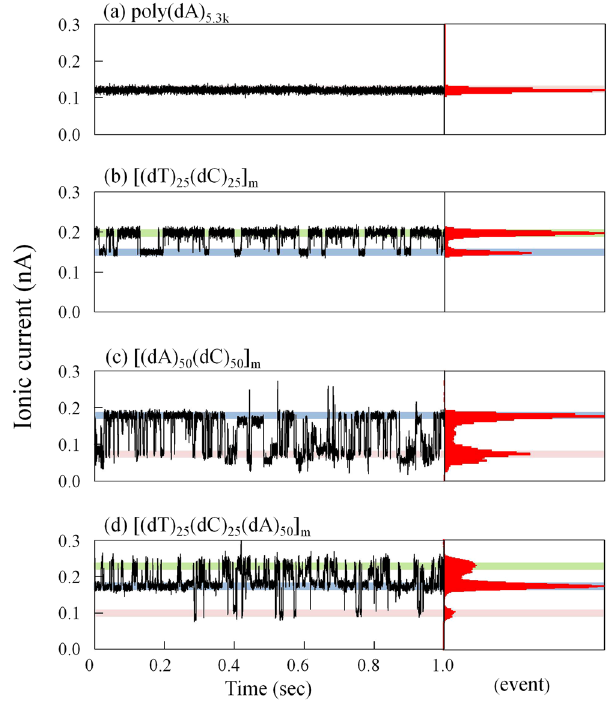
Figure 6. Short-term time trace of the ionic current while the homopolymer or block copolymer remained in the nanopore. Typical time trace of the ionic current for 1 sec while ( a ) poly(dA) 5.3k , ( b ) [(dT) 25 -(dC) 25 ] m , ( c ) [(dA) 50 -(dC) 50 ] m , and ( d ) [(dT) 25 -(dC) 25 -(dA) 50 ] m remained in the nanopore. Each applied voltage was 100 mV. Each current signal was filtered at 2 kHz. The values of the ionic-current blockades at the intensity peaks in each histogram were ( a ) 118 pA; ( b ) 148 pA and 197 pA (shaded blue and green, respectively); ( c ) 72 pA and 176 pA (shaded red and blue, respectively); and ( d ) 98 pA, 173 pA, and 222 pA (shaded red, blue and green,